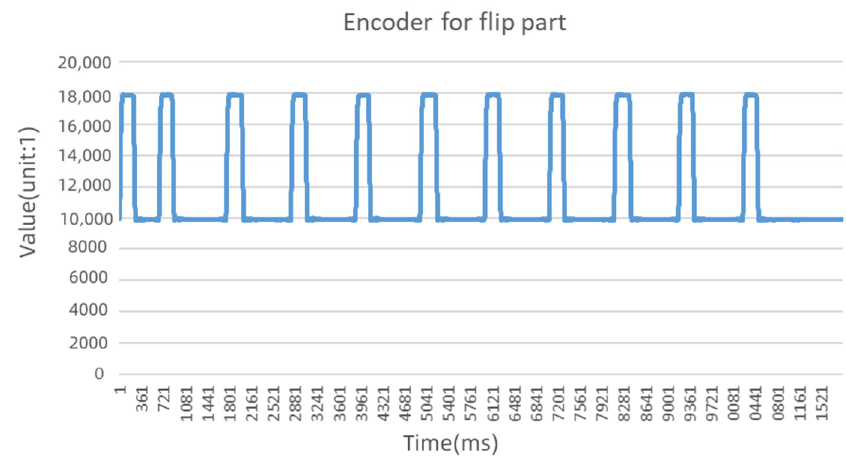
Figure 4. The time series of the flip mechanism. Table 1. The structure of the experimental data.